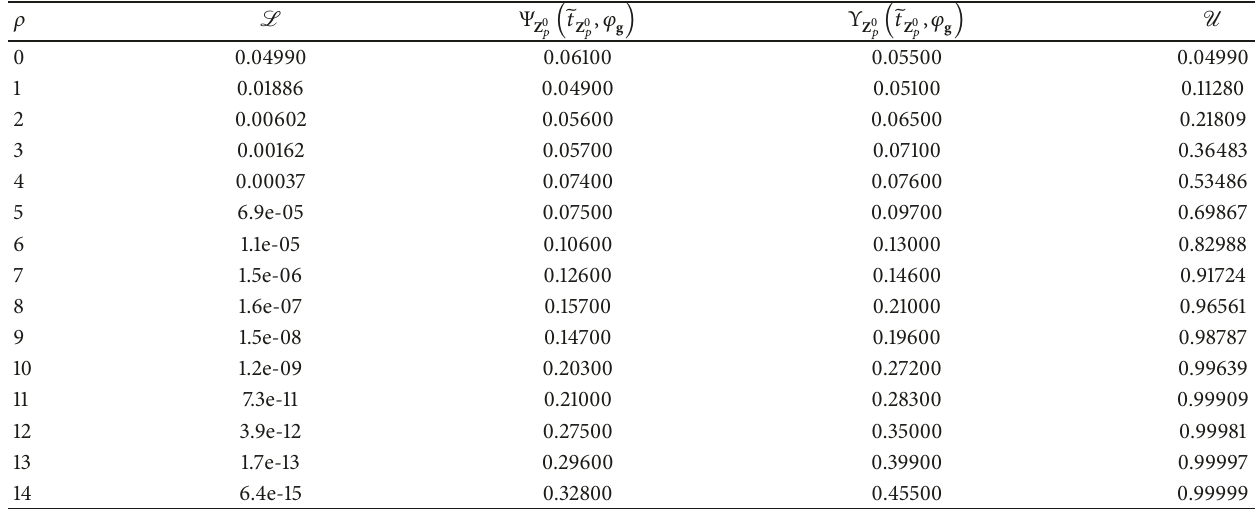
(̃𝑡 (̃𝑞 , 𝜑 ) and Υ ,𝜑 ) . The size of the test is 𝛼 = 0.05 . Z 0 𝑝 Z 0 𝑝 g Z 0 𝑝 Z 0 𝑝 g